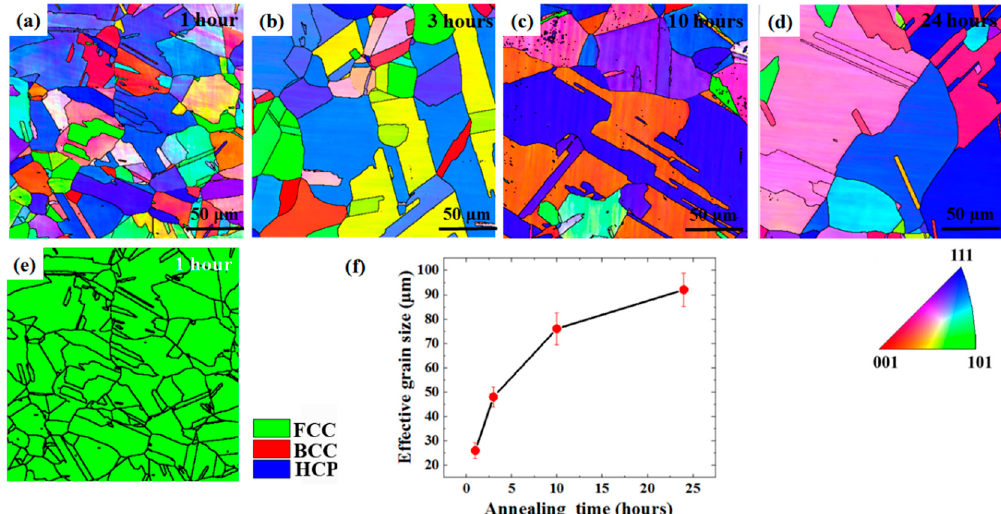
Figure 2. Inverse pole figure (IPF) map of the 304 stainless steels after annealing at 1100 °C for different time durations: ( a ) 1 h, ( b ) 3 h, ( c ) 10 h, and ( d ) 24 h. ( e ) Phase map of the microstructure corresponding to Figure 2a. ( f ) Variation of initial effective grain size of the 304 stainless steel samples with annealing time.